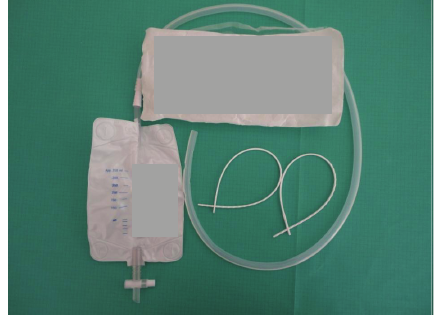
Figure 1: Type of a 30-Fr passive drainage